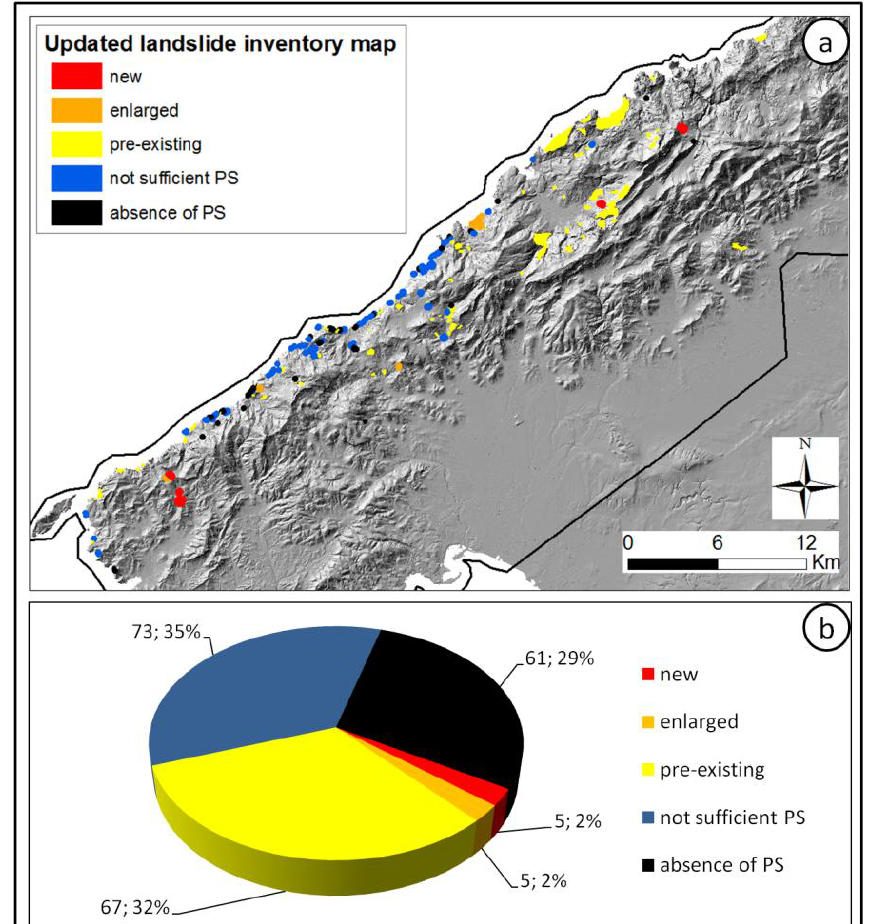
Figure 6. ( a ) Updating of Landslide inventory map in Tramuntana Range and ( b ) statistical evaluation of landslide database